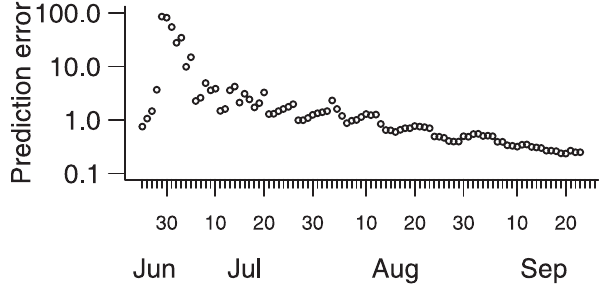
Figure 4. Quantification of predictive error. Posterior absolute deviation between predicted average ILIs per GPFD and observed average, with error averaged over the one week period following the time the forecast is made.